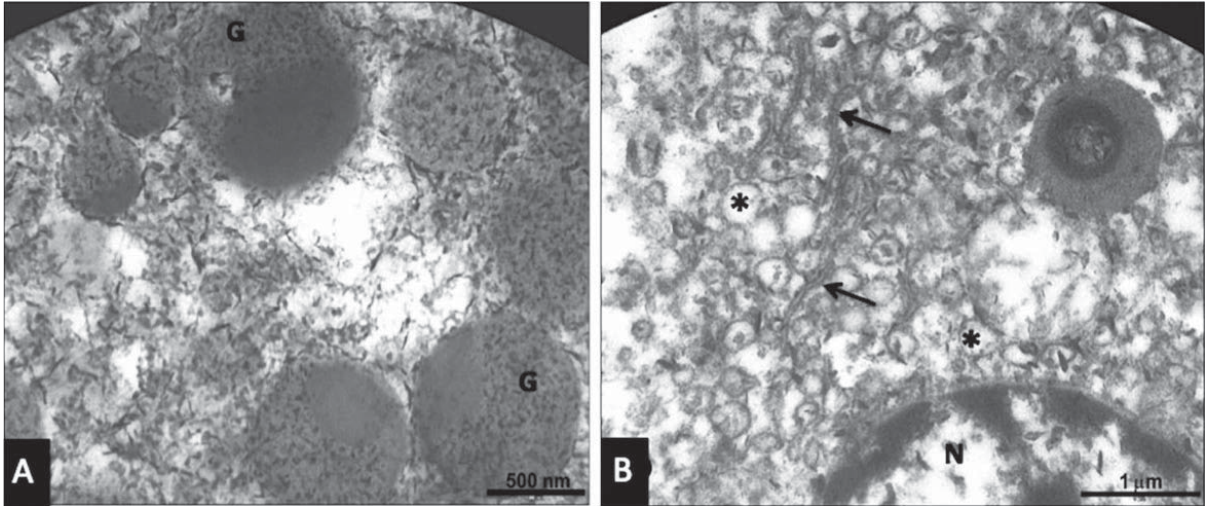
Figure 6- Transmission electron microscopy (TEM) of a human sublingual gland with advanced autolysis (male, 71 years old). A: Secretion granules of a serous cell (G) with partially preserved content and destruction of cytoplasmic organelles; B: Cisternae (arrow) and vesicles (*) of the rough endoplasmic reticulum and preserved nucleus (N) of a serous